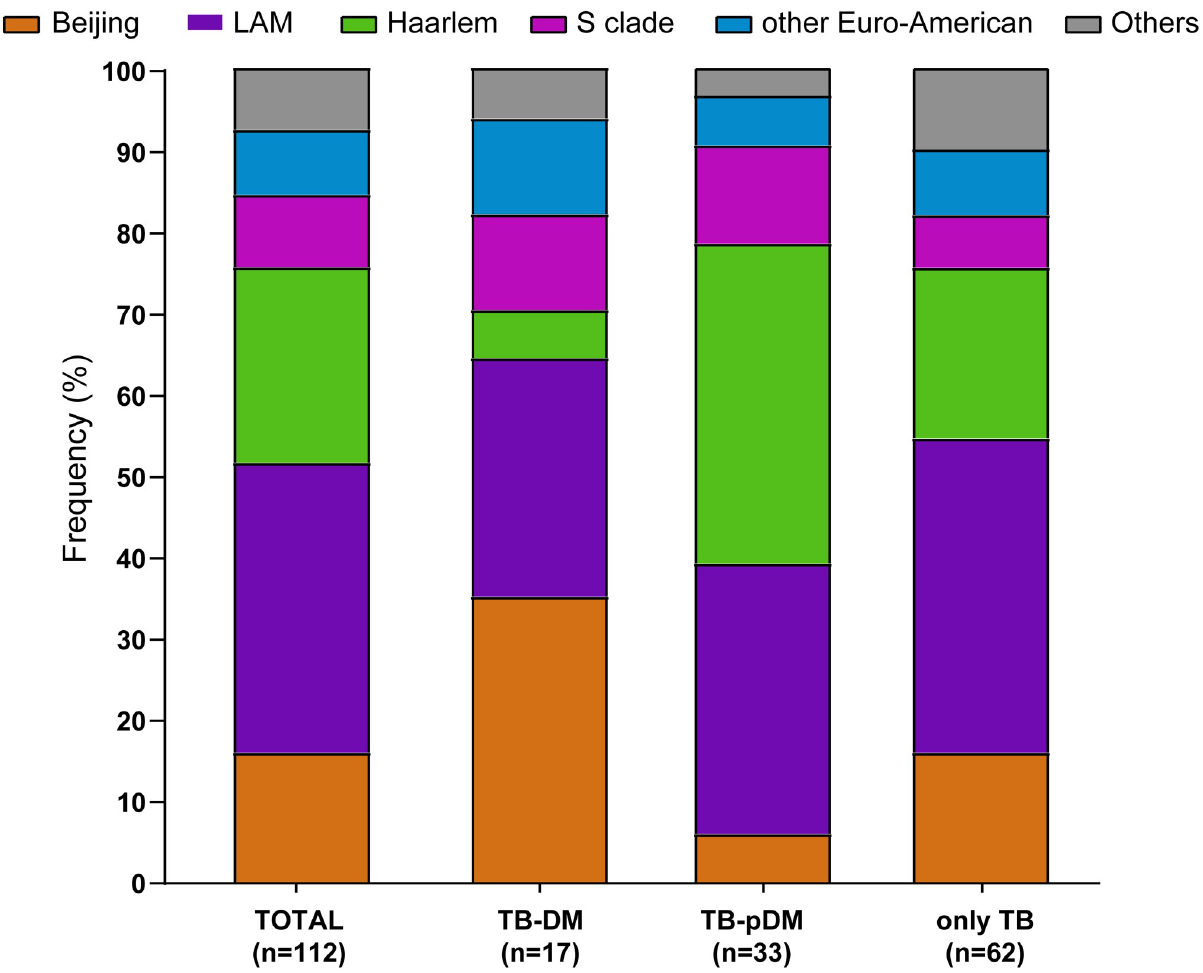
Fig 2. Frequency distribution of M . tuberculosis strain lineages among TB patients with diabetes, prediabetes and normal glucose levels (normoglycemic). Bar diagrams show the frequency in percentage of each lineage in each of these three categories. M. tuberculosis strain lineage assignments were based on 24-MIRU-VNTR analysis and whole genome sequencing (see method). The lineages H37Rv, X, Ghana, S, S-type were grouped under the label of “others” as the corresponding strains are very few in numbers.